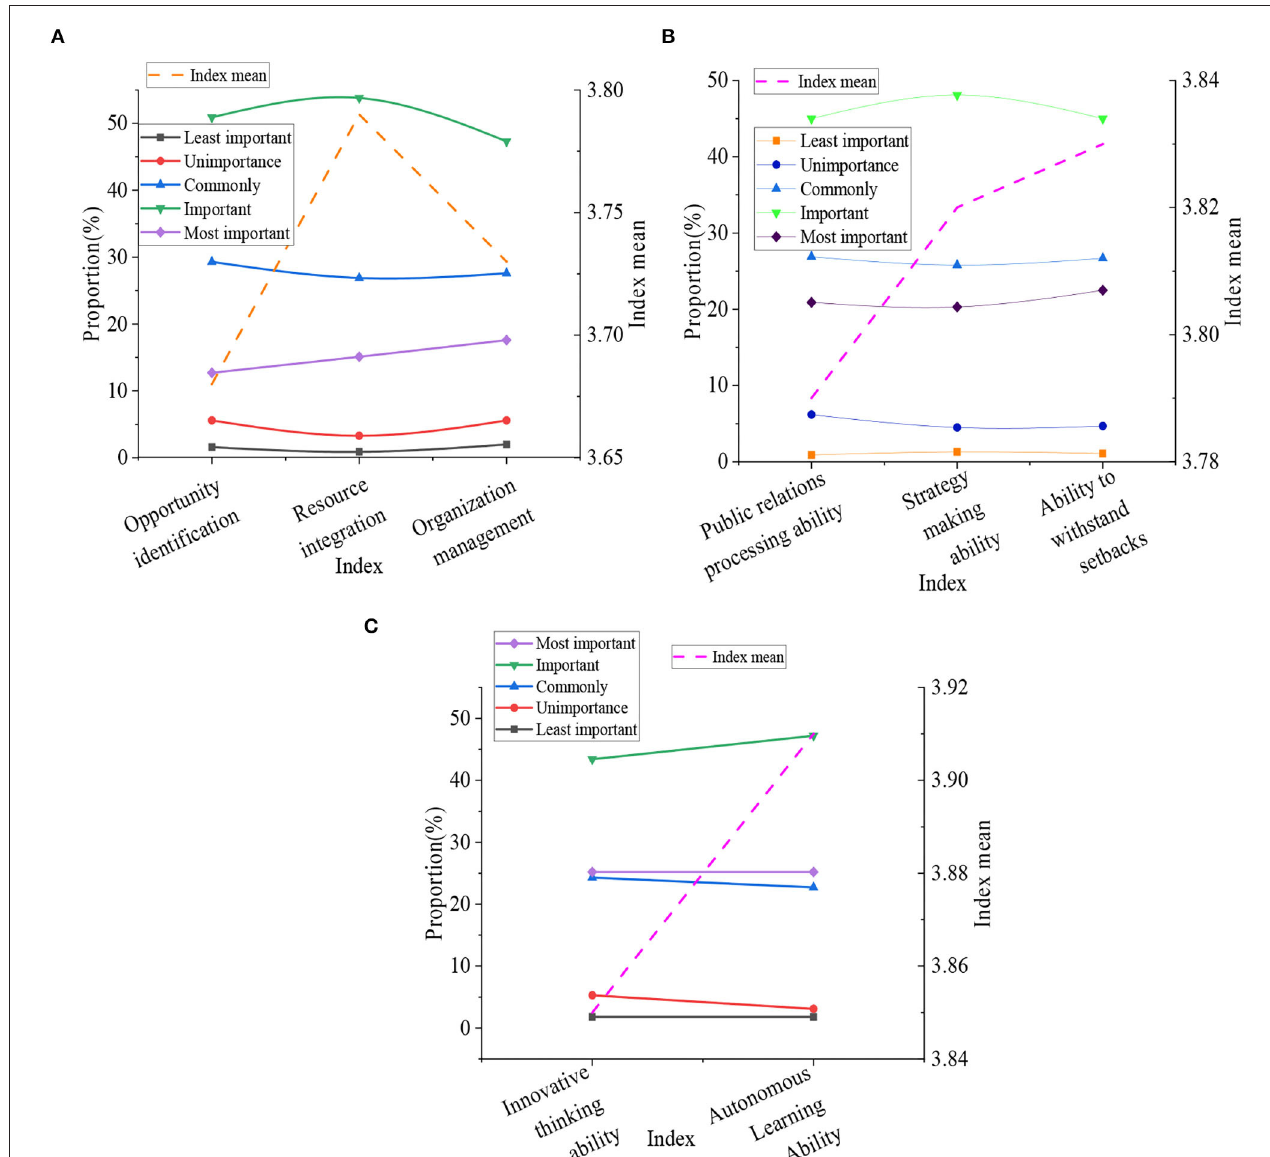
FIGURE 10 | The basic situation of entrepreneurial abilities of college students (A) shows the recognition, integration and management ability of college students’ entrepreneurship; (B) is the public relations, strategy formulation and frustration ability of college students; (C) means the thinking and autonomous learning ability of college